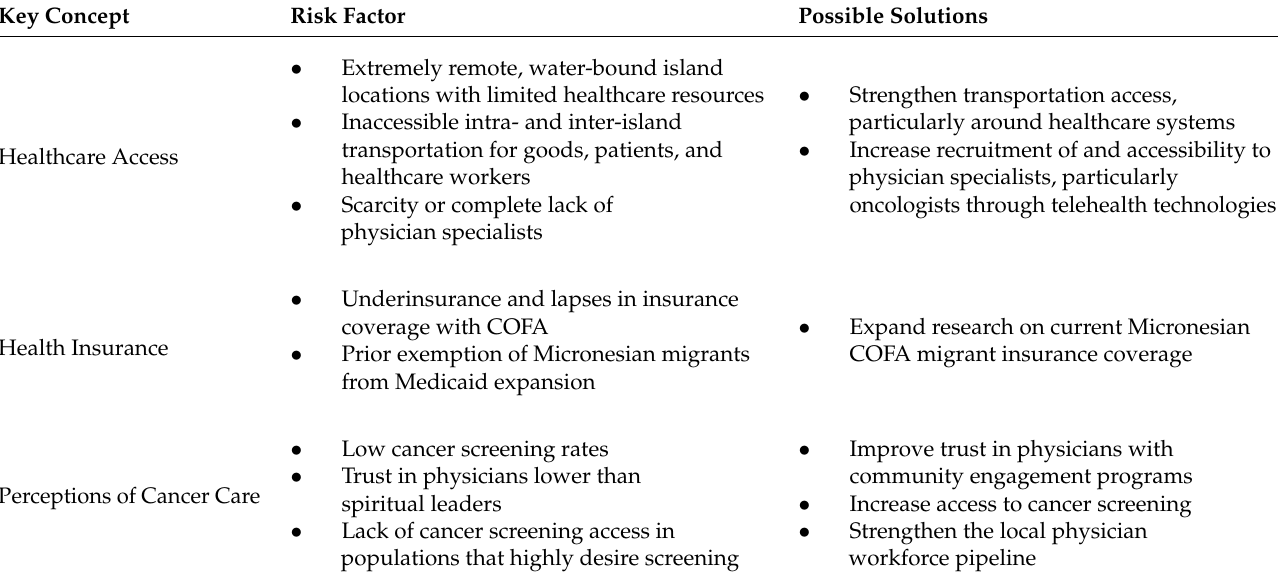
Table 6. Risk factors and possible solutions for healthcare access, health insurance, and perceptions of cancer care related to Micronesians with respect to cancer. Abbreviation: COFA—Compact of Free